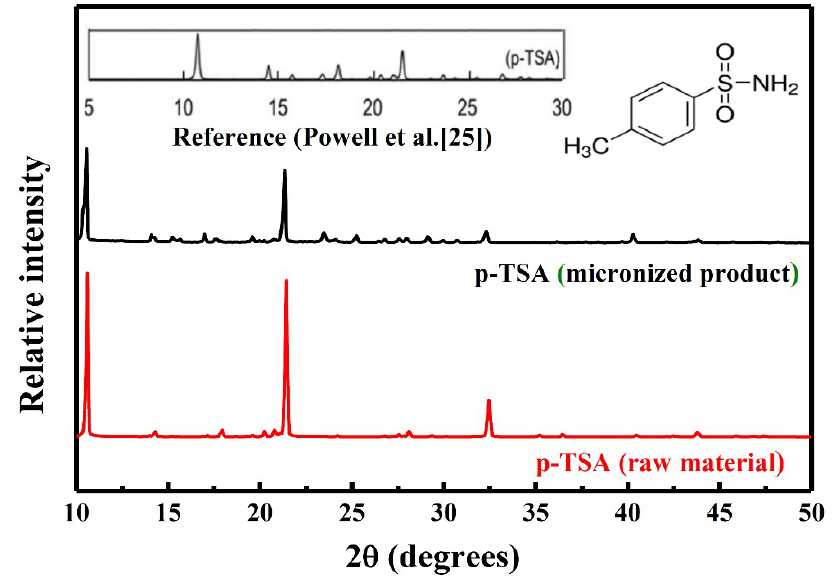
Figure 7. XRD patterns of raw and micronized p-TSA.